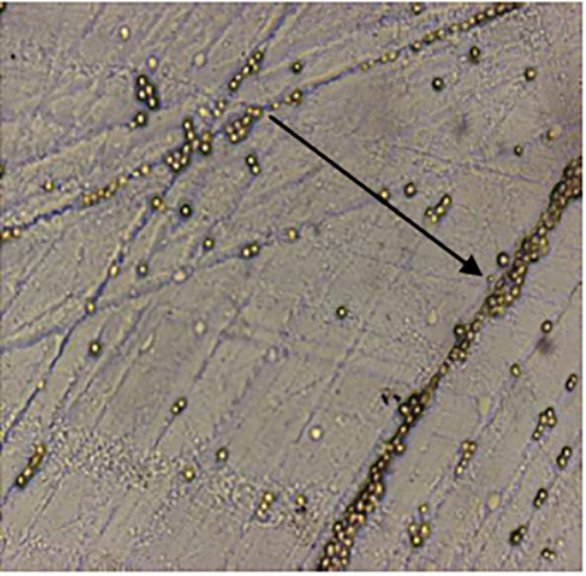
The representative and reference isolates NGES 9, NGES 6, NGES 3 and N . australiensis GU597032 with similar sequences and length in the 5.8S (173 bp) were grouped together. NGES 4, NGES 5, NGES 7 and NGES 8 formed a clade to each other and showed similarity to the ITS1 (35bp). NGES 10 and N . fowleri (AY033619) formed a clade with each other showing similar sequences (Fig 4).